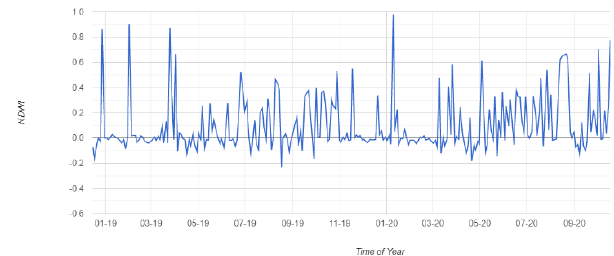
Figure 4: Time Series of NDWI for Owasco Lake